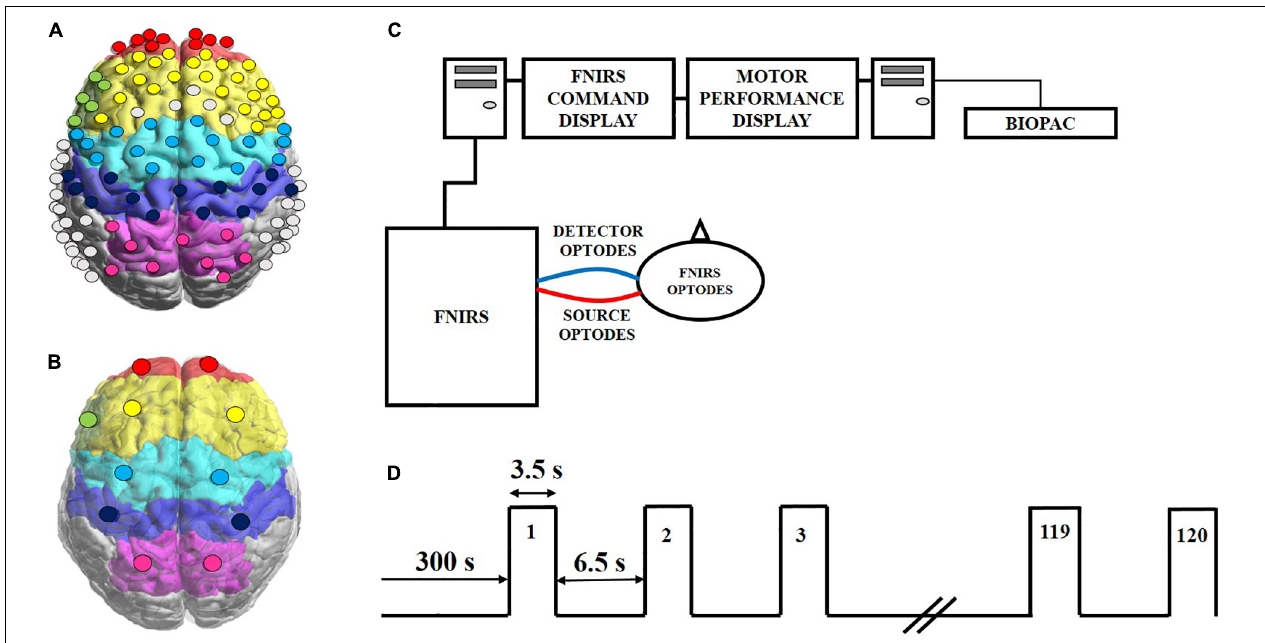
FIGURE 1 | Experimental set up and protocol timeline for the handgrip task. (A) FNIRS 111-channel layout with eleven regions of interest (ROIs) covered by the probe geometry: left and right frontopolar (lFP; rFP) (red), left and right pre-frontal cortex (lDLPFC; rDLPFC) (yellow), Broca’s area (green), left and right pre-motor cortex (lPMC; rPMC) (light blue), left and right primary motor and sensory cortical (lM1/S1; rM1/S1) areas (purple), and left and right sensory association cortex (lSAC; rSAC) (pink). (B) Each circle shows the spatial average of the probe coordinates in each ROI, per brain hemisphere. These averaged probe locations served as reference points for plotting dPTE and DC between ROIs in this work. (C) Schematic of the experimental set-up of the fNIRS (LABNIRS) system and the BIOPAC handgrip force sensor system with one representative source-detector channel shown for simplicity. (D) The handgrip task protocol, starting with a 5-minute baseline. Subjects performed intermittent handgrip contractions for 3.5 s followed by 6.5 s of rest for 120 blocks at 100%